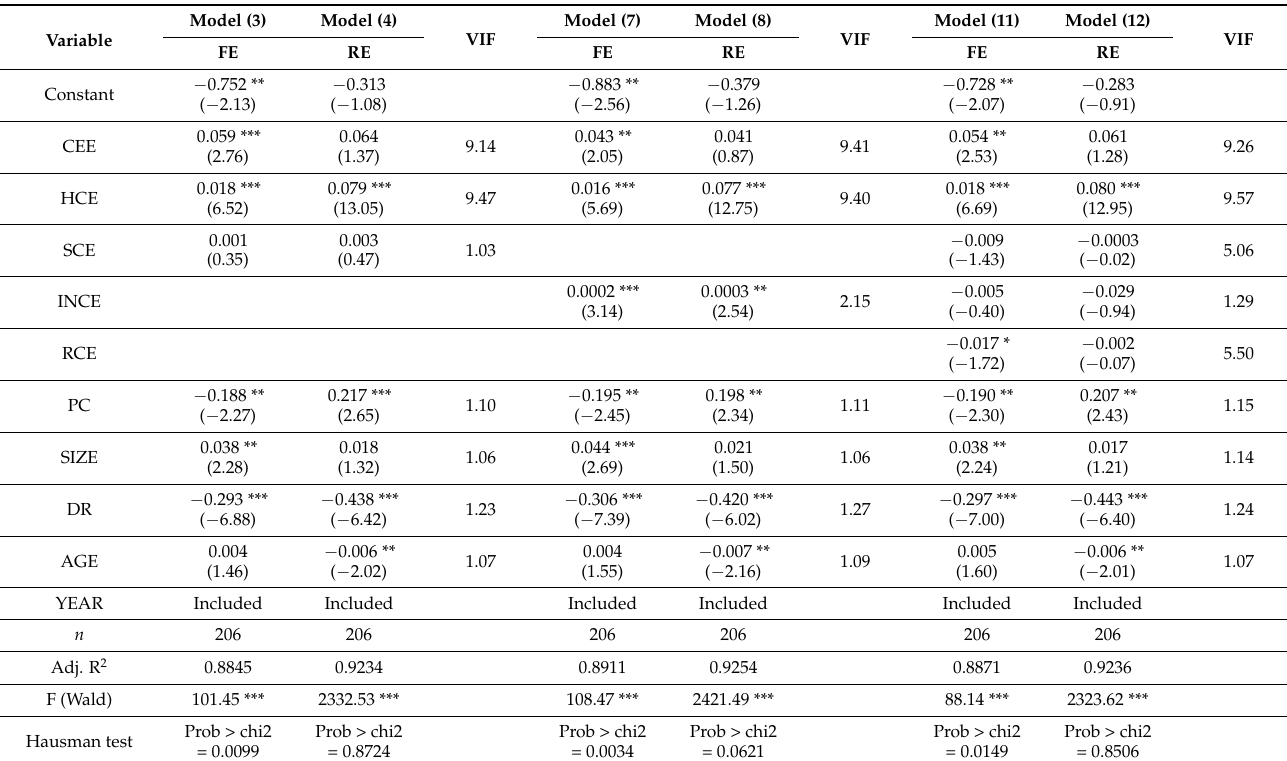
Table 9. Regression results of Models (3), (4), (7), (8), (11), and